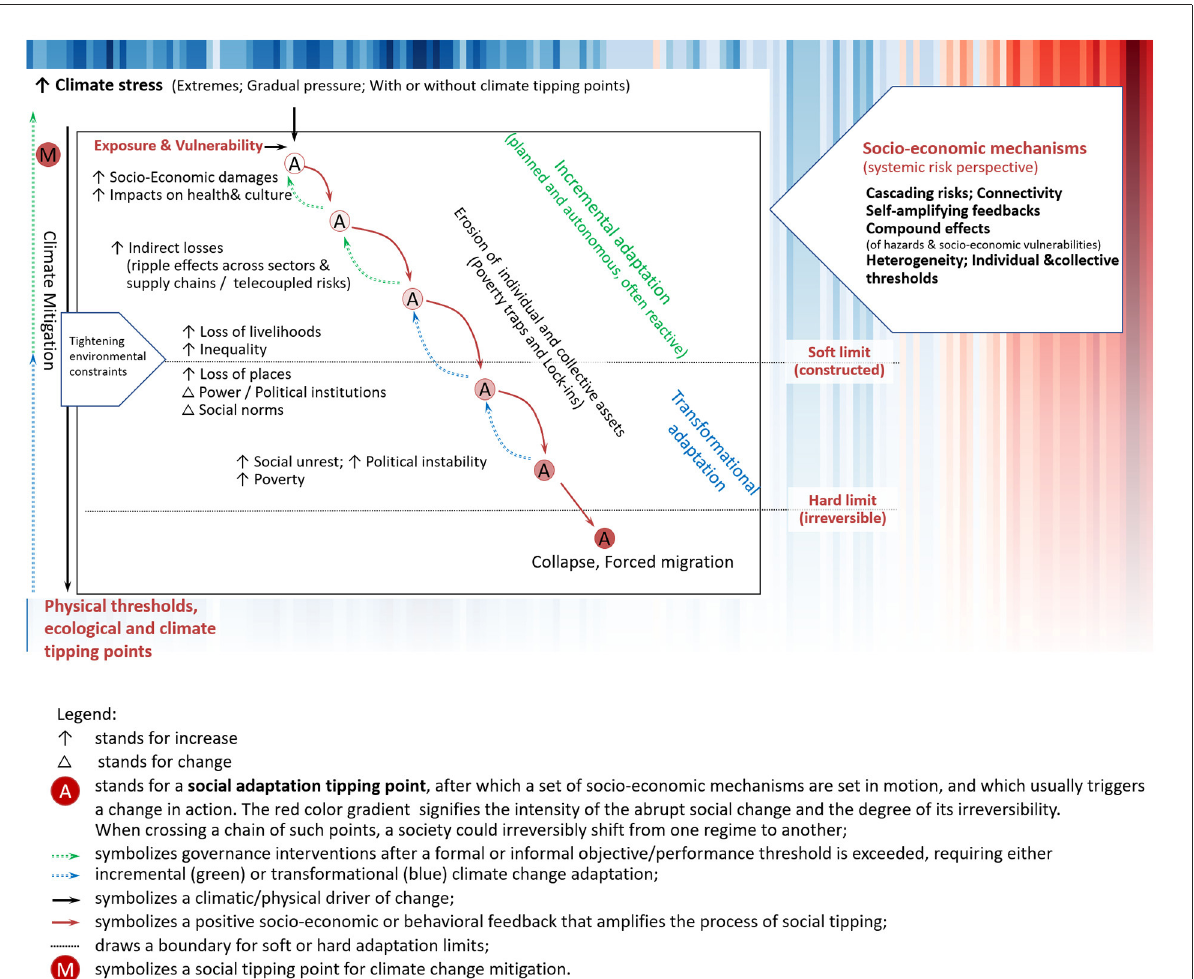
FIGURE1 Adaptation limits as social tipping